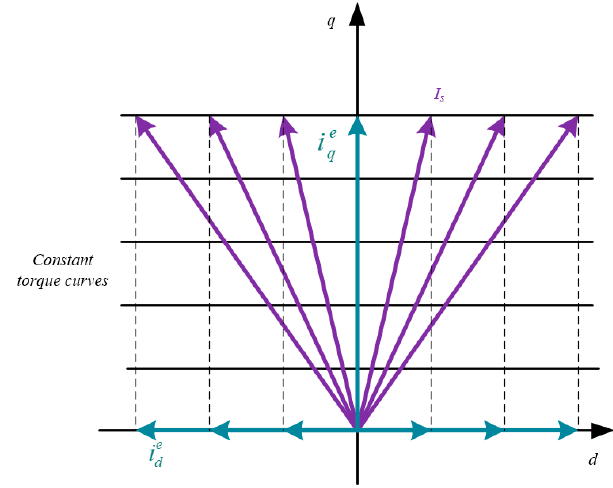
Figure 2. Voltage and current vectors when: ( a ) i ed < 0, i eq > 0; ( b ) i ed = 0, i eq > 0.